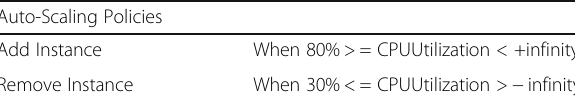
Table 2 Auto-Scaling polices Auto-Scaling Policies